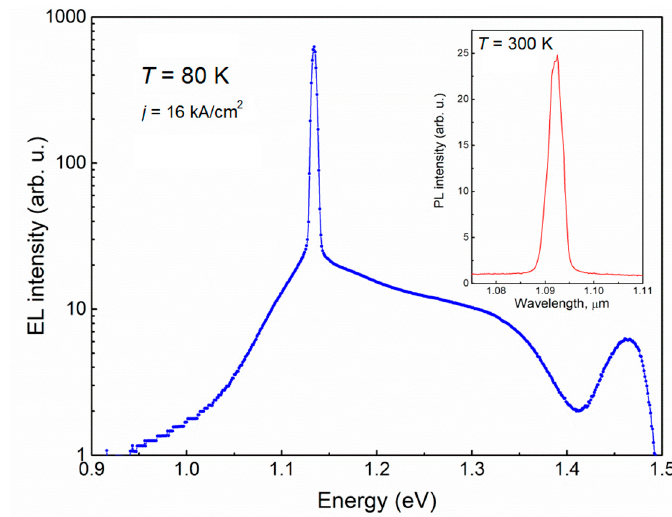
Figure 2. Electroluminescence spectrum measured for the laser diode at the temperature of 80 K. The room temperature (RT) dependence of photoluminescence (PL) intensity on wavelength is presented in the inset.